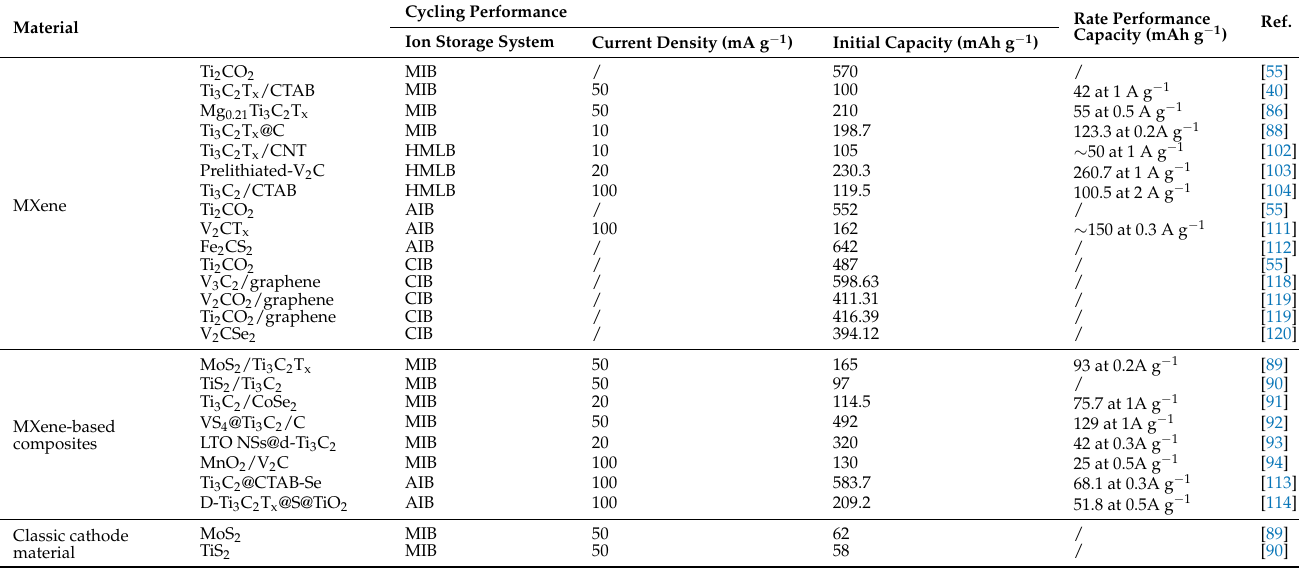
Table 3. Applications of MXene and MXene-based composites in MIBs/HMLBs, AIBs, CIBs.